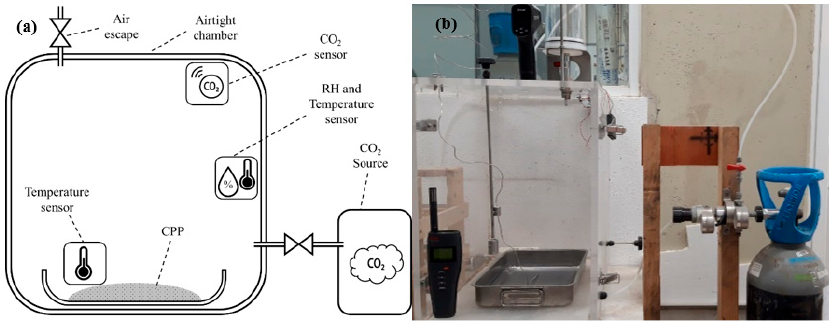
Figure 1. Schematic setup ( a ) and real setup ( b ) of the carbonation process equipment.